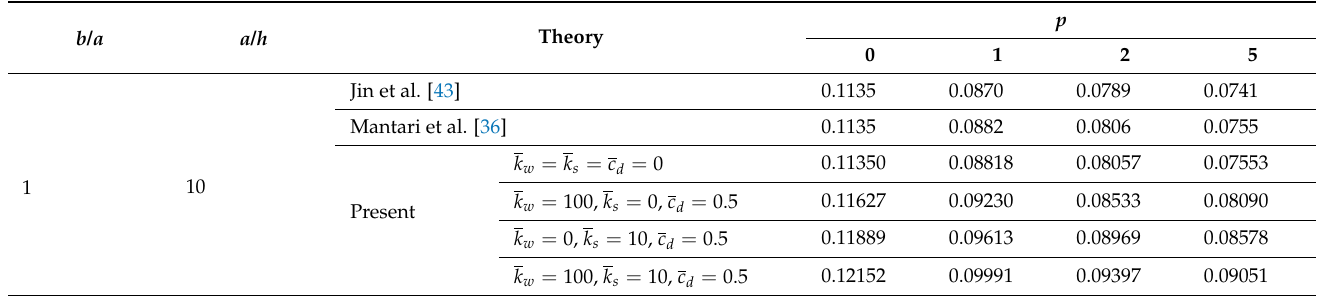
Table 6. Non-dimensional fundamental frequencies ˆ ω = ω h plates on Visco-Winkler-Pasternak